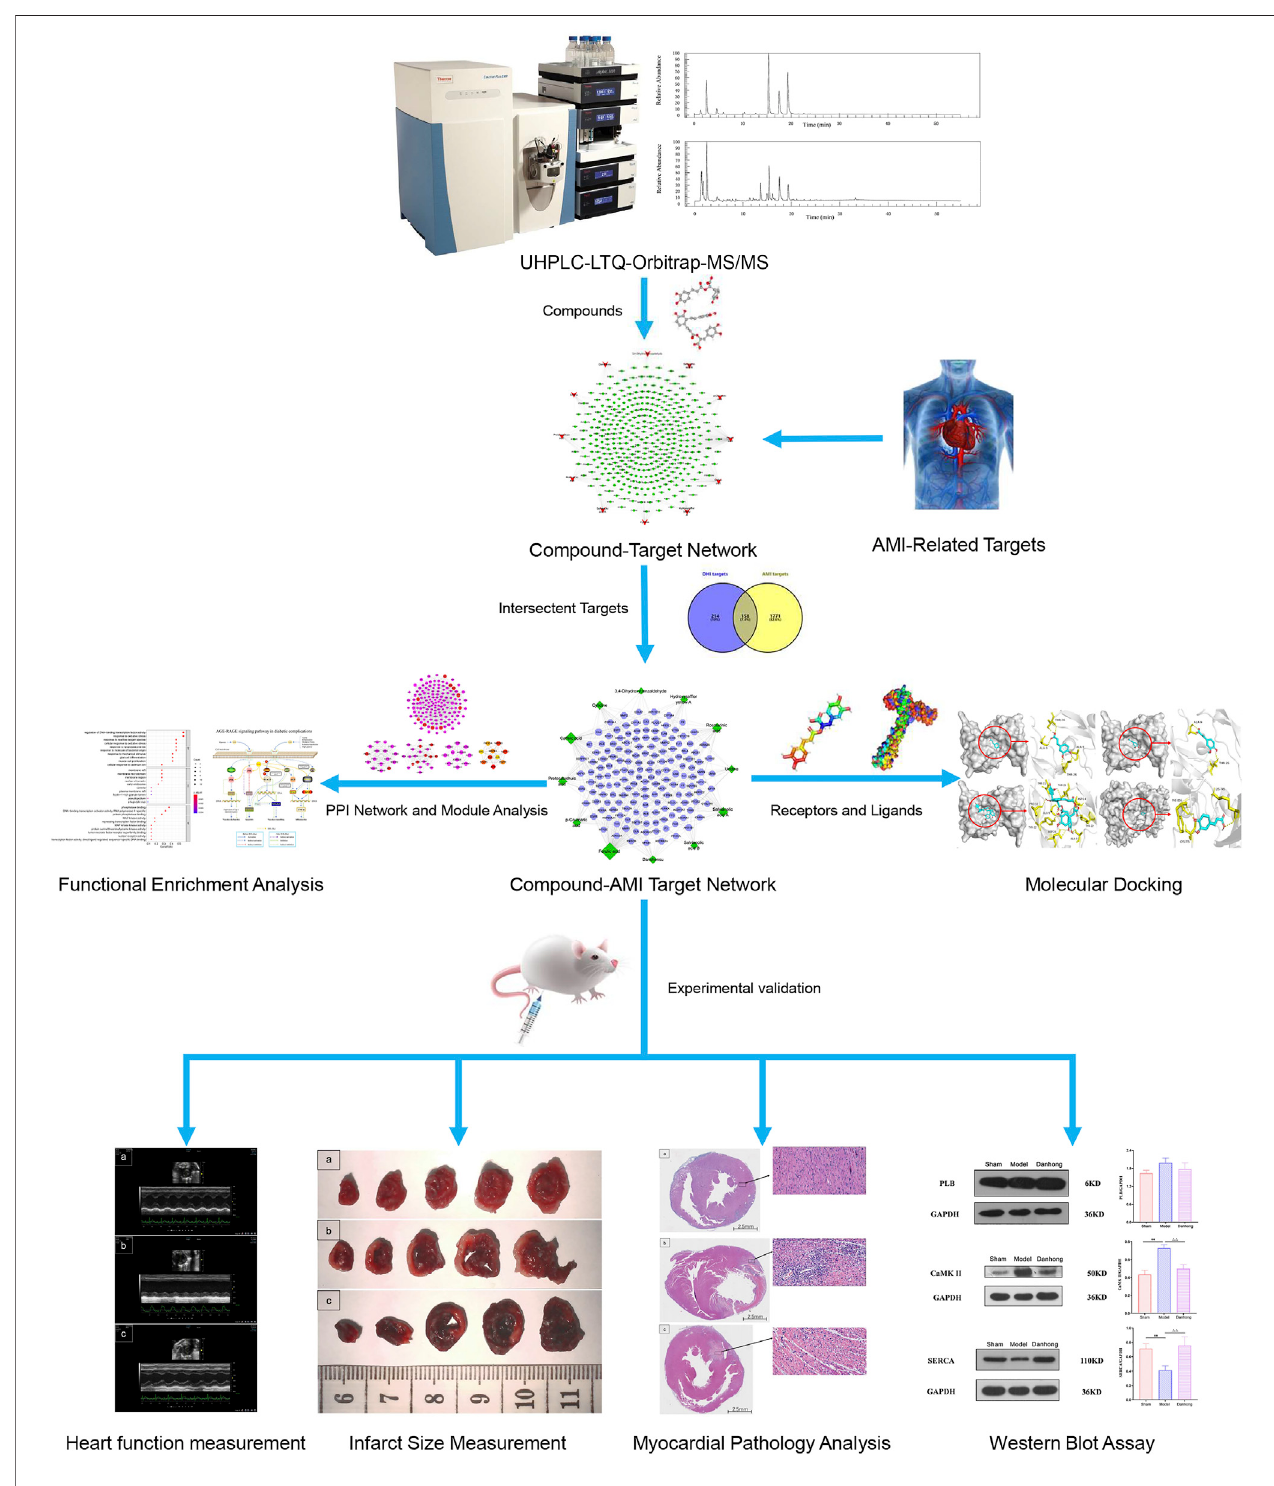
FIGURE 1 | Work fl ow diagram of this study.